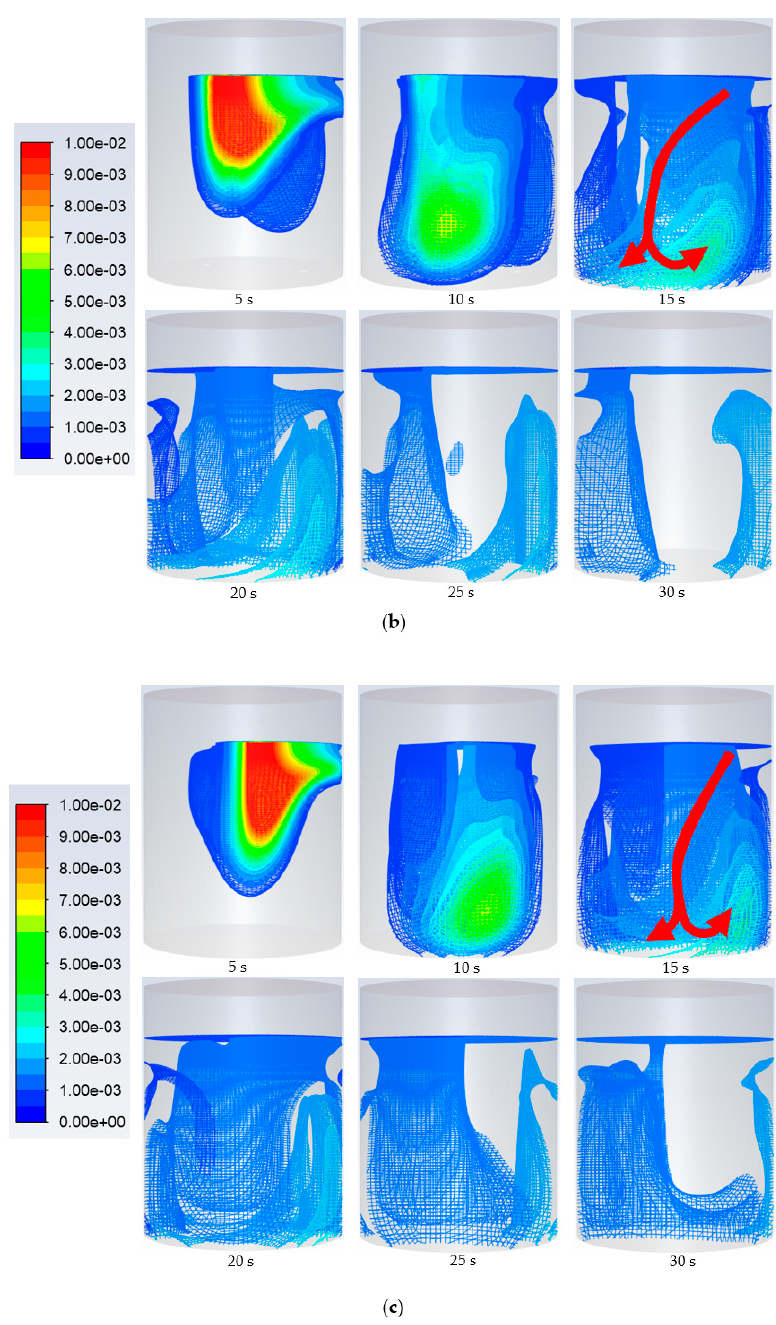
Figure 13. Tracer homogenization for a flow rate of 1.63 L ‧ min − 1 : ( a ) 90°; ( b ) 135°; and ( c ) 180°.